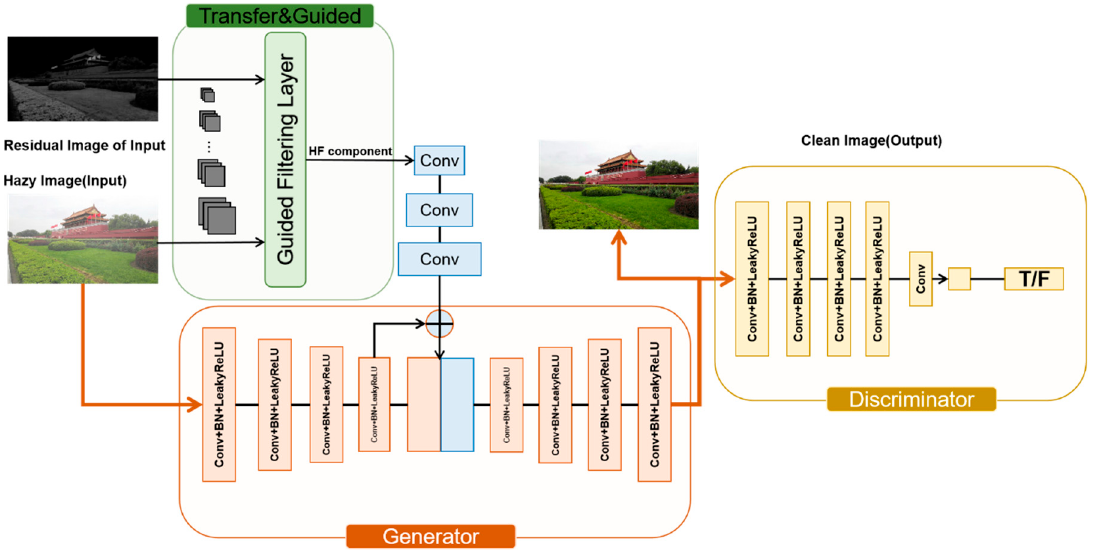
Figure 3. Intermediate results of the decomposition process.